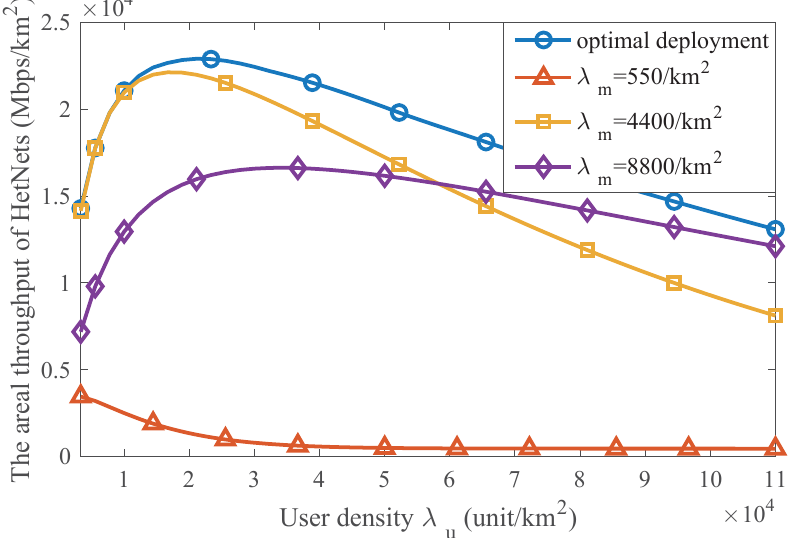
Figure 8. Comparison between the optimal densification deployment and suboptimal ones. P m = 60